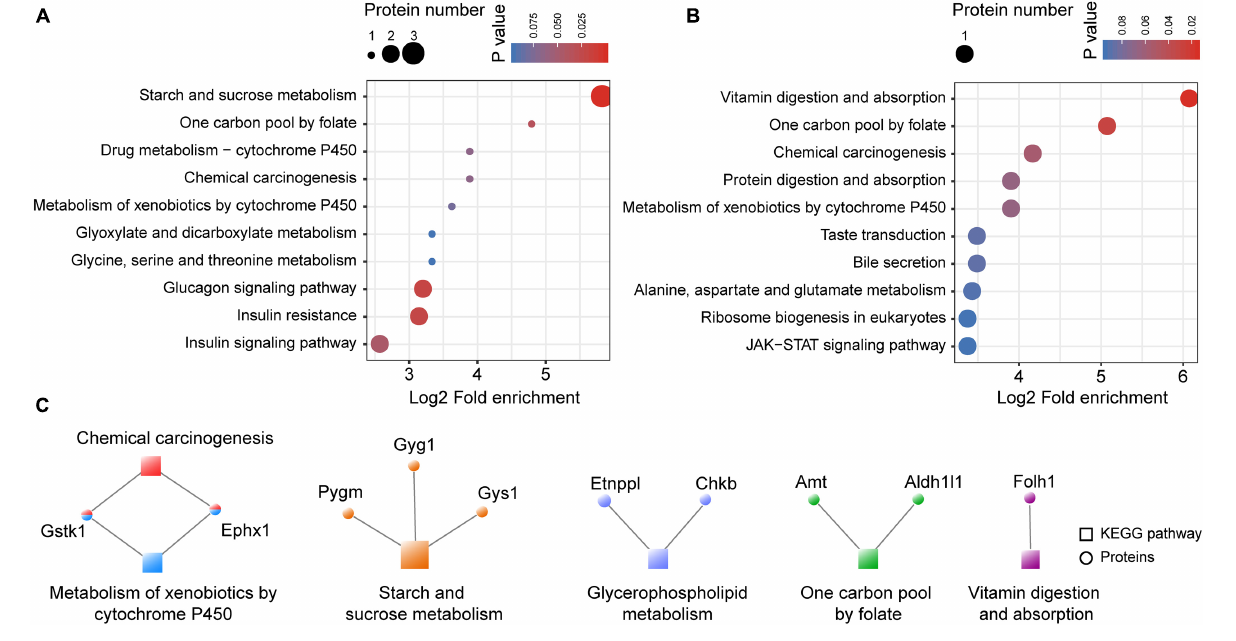
FIGURE 8 | The KEGG enrichment of differentially expressed proteins in the mPFC. (A) The KEGG enrichment of downregulated proteins in the mPFC. (B) The KEGG enrichment of upregulated proteins in the mPFC. (C) Co-expression network of the differentially expressed proteins and their enriched KEGG pathways. The circular nodes represent the proteins and the square nodes represent the KEGG